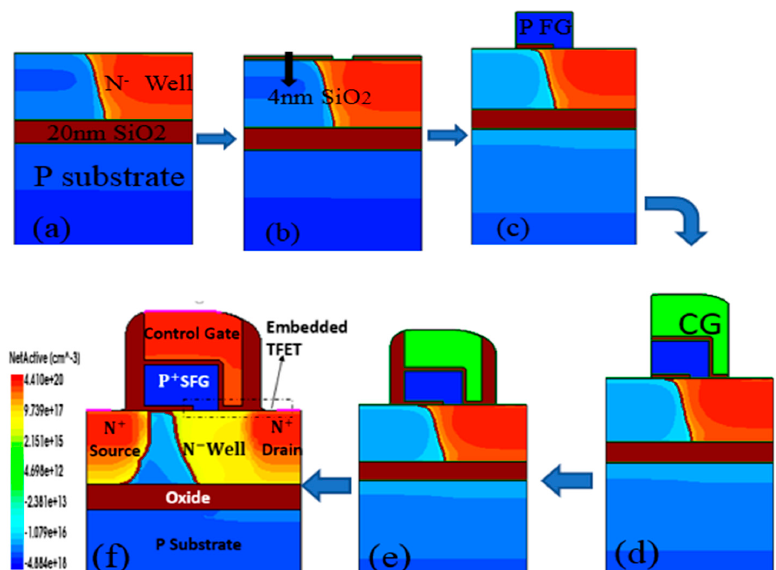
Figure 1. Schematic illustration of the device fabrication process. ( a ) SOI substrate and N- well formation. ( b ) 4 nm SiO 2 deposition. ( c ) P-type floating gate formation. ( d ) Control gate and ( e ) spacer formation. ( f ) N+ doped S/D formation and doping concentration distribution of the SFG transistor based on the SOI substrate.